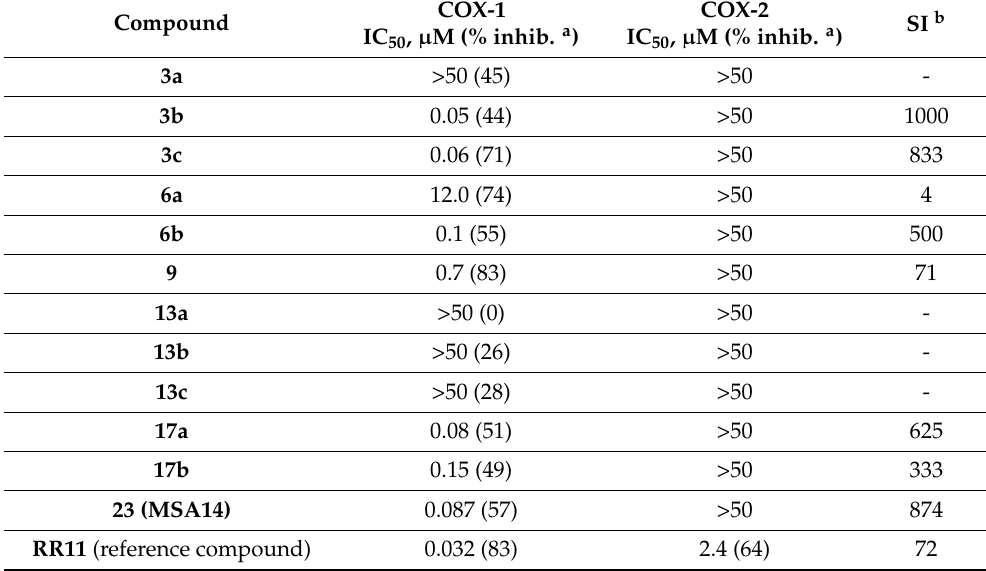
Table 2. COXs inhibitory activity (IC 50 ) of the newly synthesized